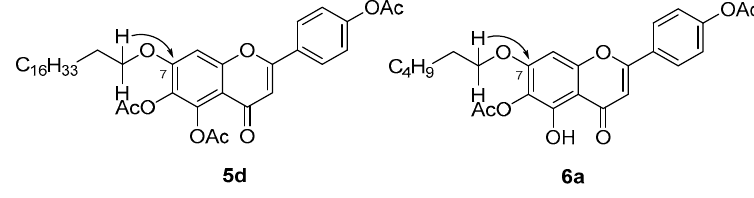
Figure 4. Key HMBC correlations of compounds of 5d and 6a . Table 1. In vitro antiproliferative activities of compounds.